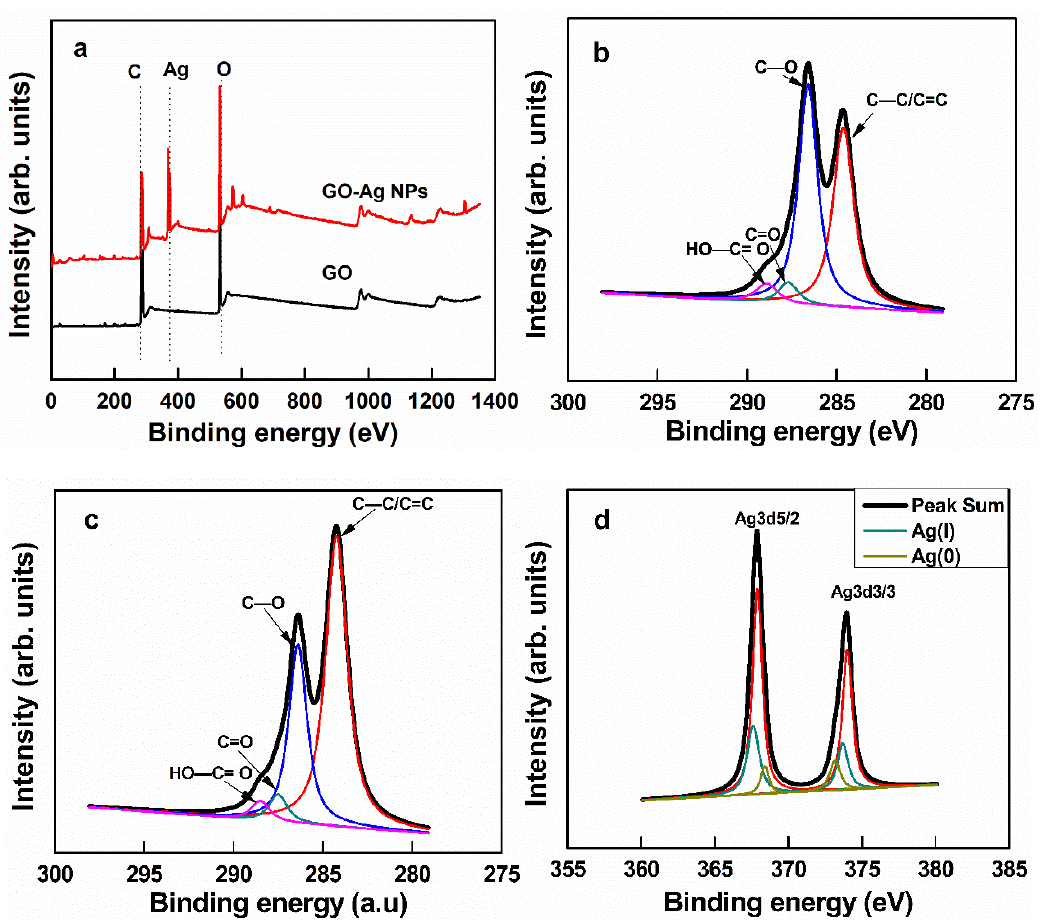
Figure 3. Full scan XPS spectra of GO and GO–Ag NPs ( a ), XPS spectra for C1s deconvolution of GO ( b ), XPS spectra for C1s deconvolution of GO–Ag NPs ( c ), and XPS spectra for Ag 3d deconvolution of GO–Ag NPs ( d ).